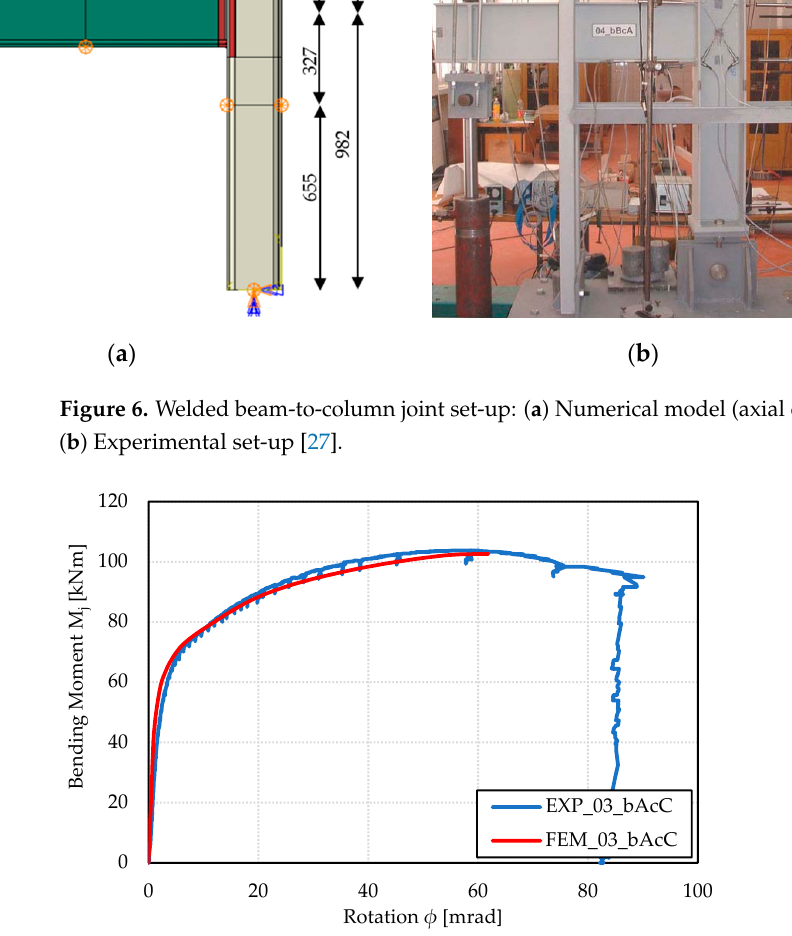
Figure 7. Experimental and FEM moment–rotation curve for steel beam-to-column joint.